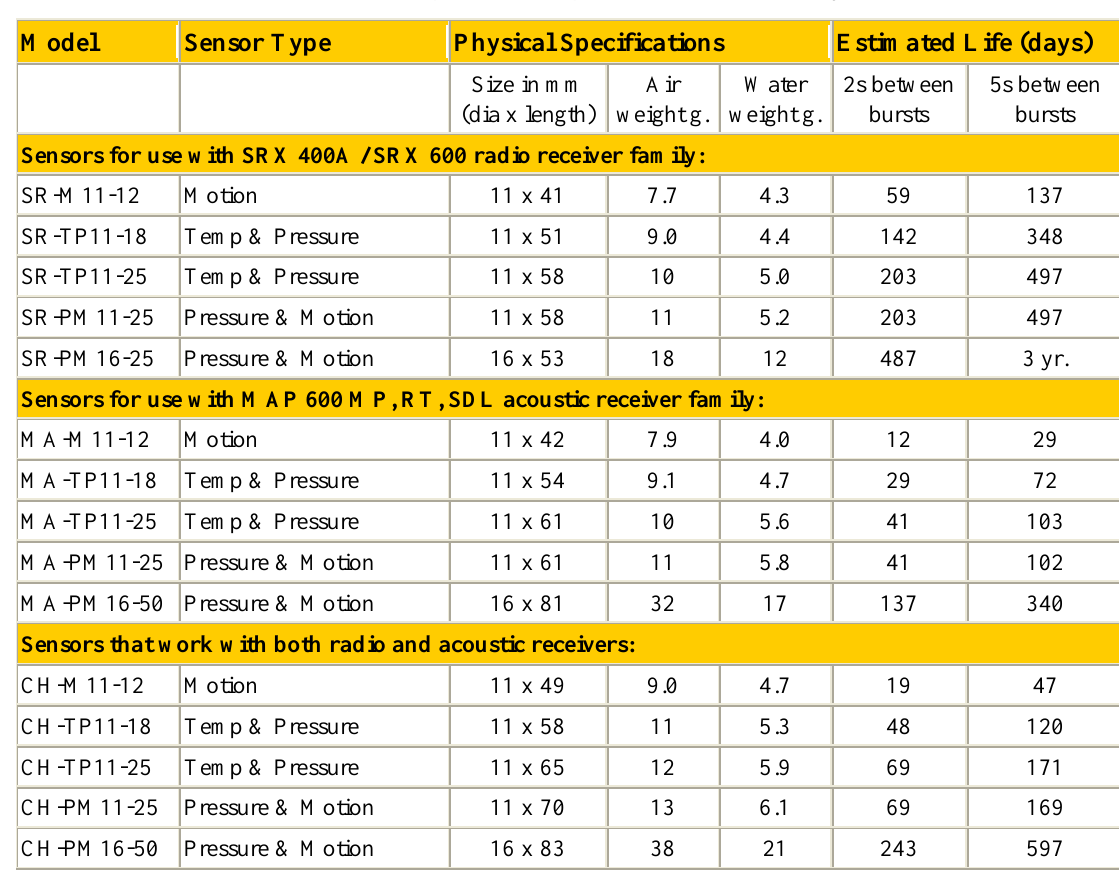
Table 1. Sample sensor specifications for the